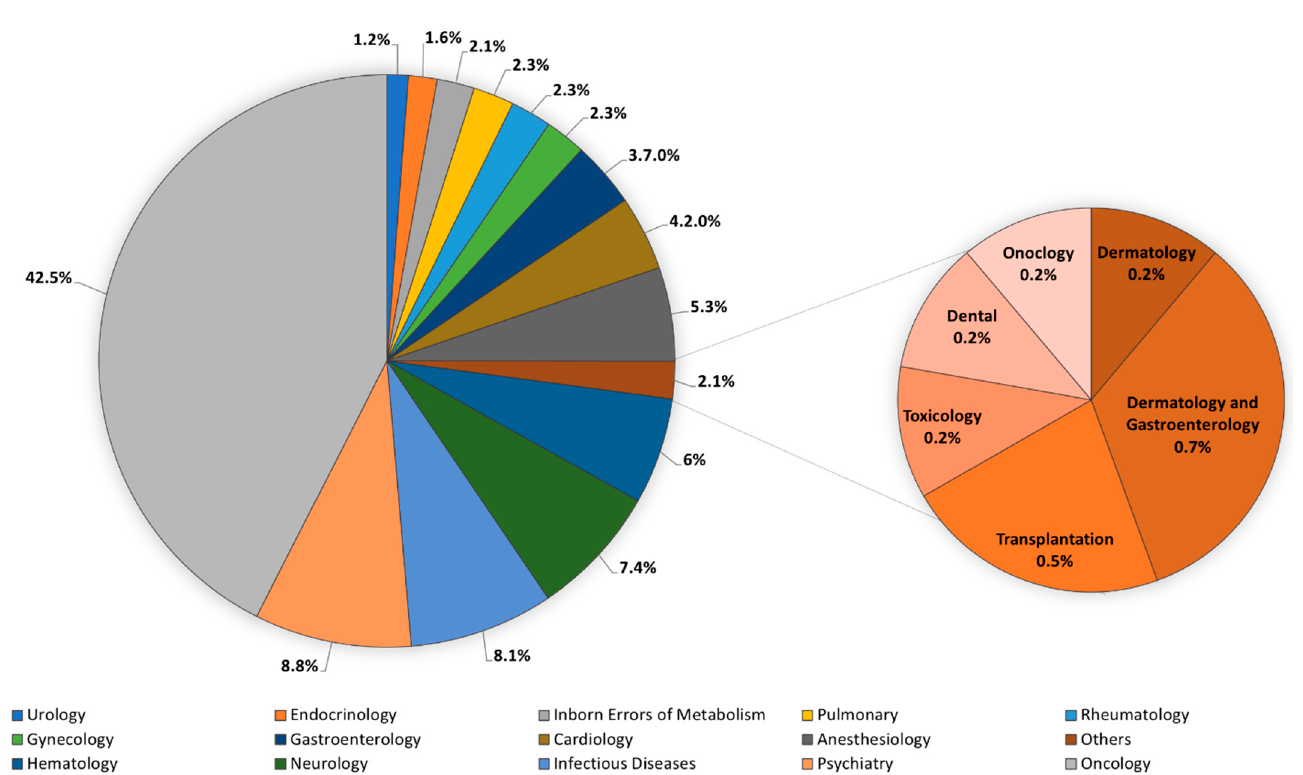
Figure 1. Pharmacogenomic Biomarkers in Drug Labeling Classified According to Field of Study. The figure was created based on data from Drugs@FDA (https://www.fda.gov/drugs/scienceresearch/ucm572698.htm) (accessed on 27 November 2021), as of August 2020. Out of 431 drugs, 42.5%